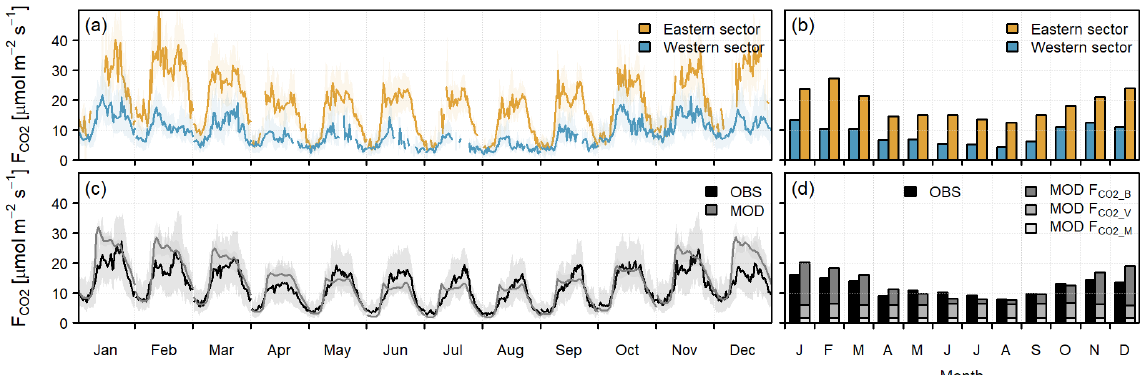
Figure 16. (a, c) Monthly median diurnal cycles (shading indicates interquartile range) and (b, d) the corresponding daily mean fluxes by month for (a–b) observed carbon dioxide fluxes separated into eastern (60–120 ◦ ) and western (210–270 ◦ ) wind sectors and (c–d) observed and modelled carbon dioxide fluxes. In panel (d) , the modelled emissions are separated into contributions from building heating ( F CO2_B ), traffic ( F CO2_V ) and human metabolism ( F CO2_M